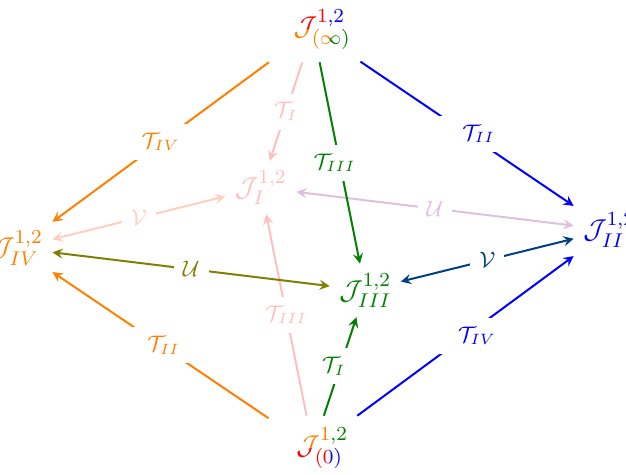
Figure 4 . The six pairs of J -functions of the SQED 2 model. The colour coding and positioning (at the vertices of an octahedron) of the J -functions reflects the associated region of validity as depicted in figure 3. Also, note two inversions, U : x